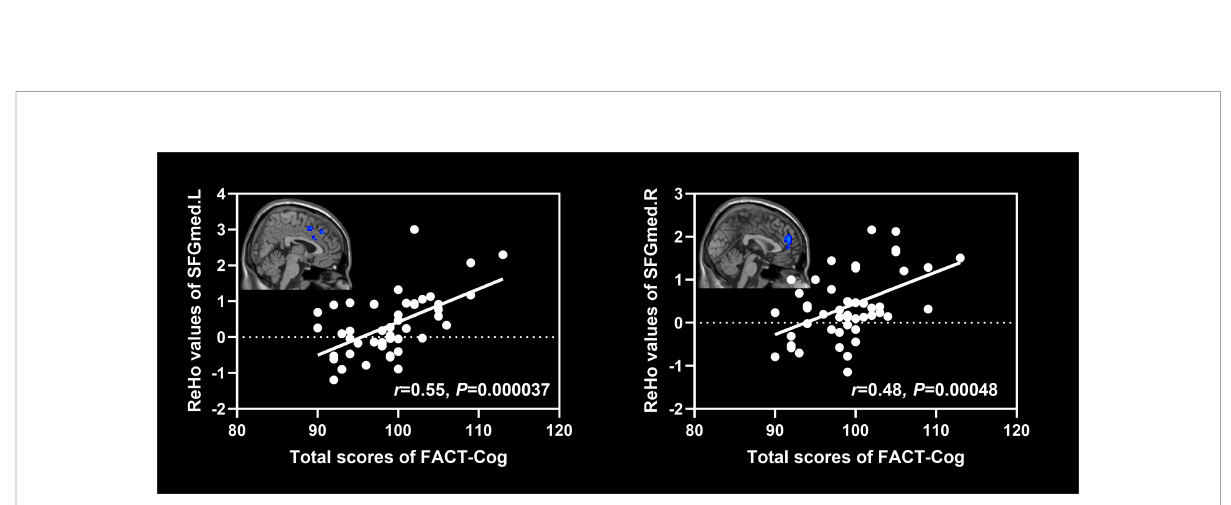
FIGURE 5 Associations between ReHo values of altered brain regions and scores of cognitive scales in NSCLC patients. NSCLC: non-small cell lung cancer. ReHo: regional homogeneity. SFGmed.L: left superior frontal gyrus (medial); SFGmed.R: right superior frontal gyrus (medial).